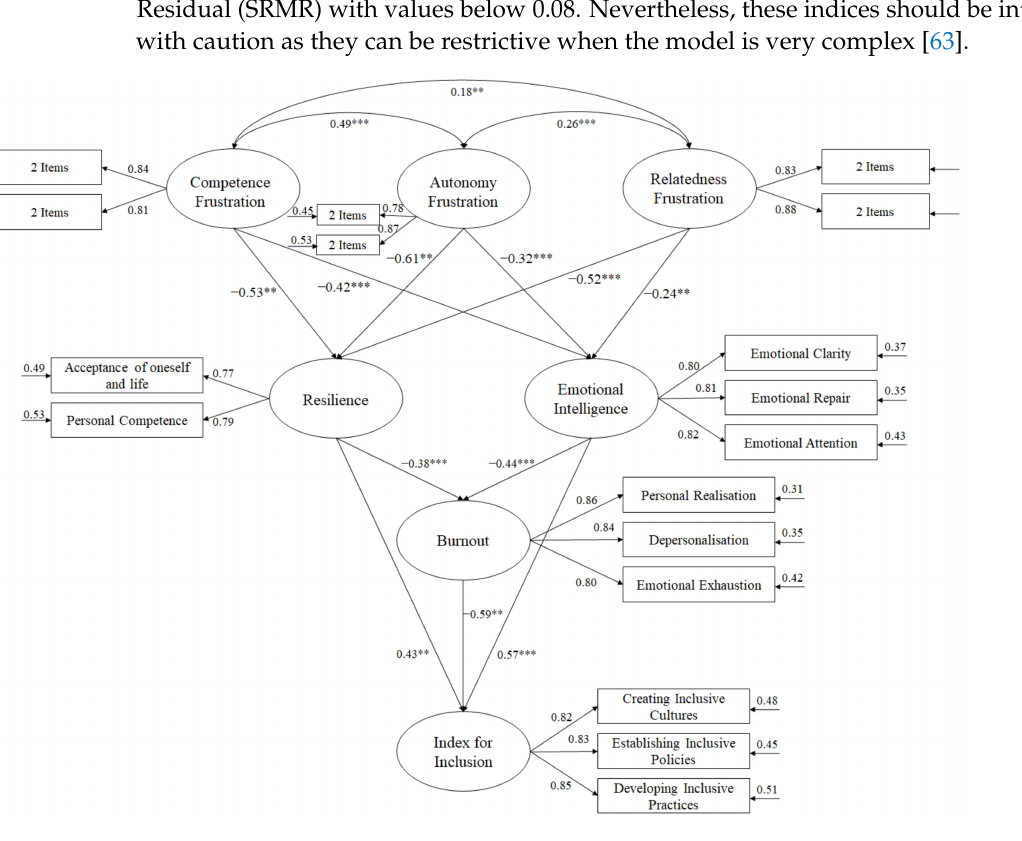
Figure 1. Structural equation model showing the relationships between variables. Note: ** p < 0.01; *** p <